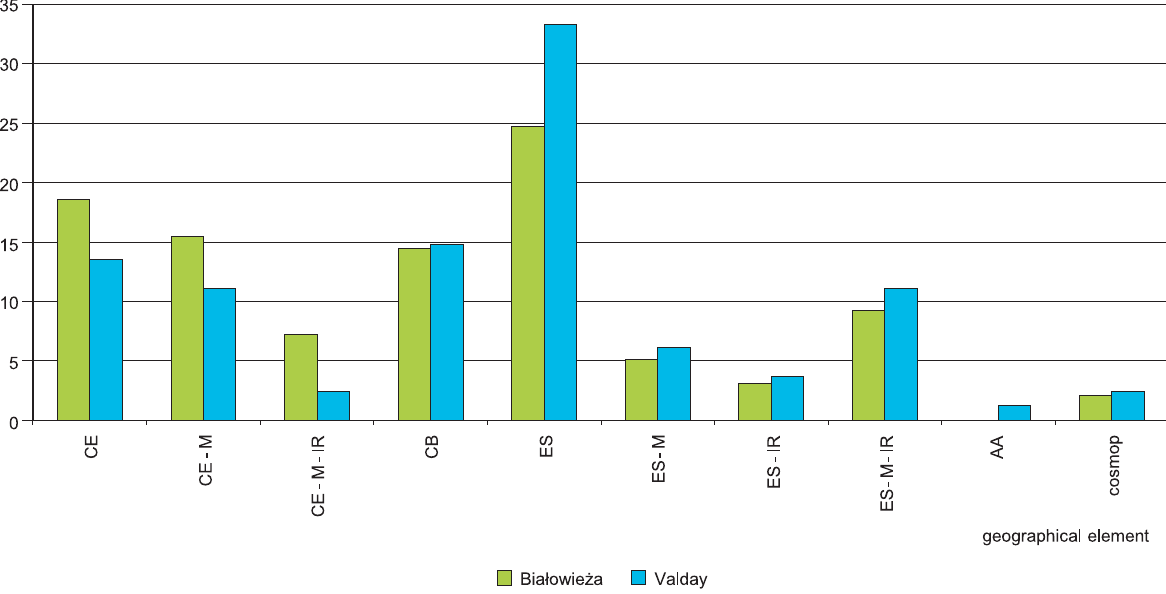
Fig. 4. Biogeographical characteristics of flora in studied forest complexes. Geographical elements and sub-elements acc. to Zając, Zając (2009) CE – Holarctic element; European-temperate sub-element CE-M – Conective element: European-temperate – Mediterranean CE-M-IR – Conective element: European-temperate – Mediterranean – Irano-Turanian CB – Holarctic element; Circum-Boreal sub-element ES – Holarctic element; Euro-Siberian sub-element ES-M – Conective element: Euro-Siberian – Mediterranean ES-IR – Conective element: Euro-Siberian – Irano-Turanian ES-M-IR – Conective element: Euro-Siberian – Mediterranean – Irano-Turanian AA – Holarctic element; Arctic-Alpine sub-element cosmop – Cosmopolitan